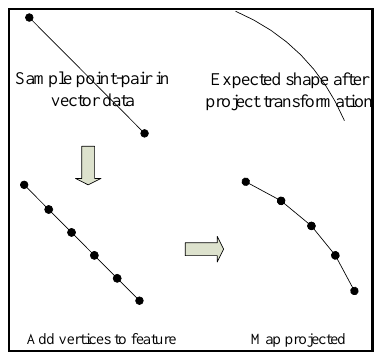
Figure 6 . Demonstration of projective deformation errors and the correction algorithm with differential geometry theory.